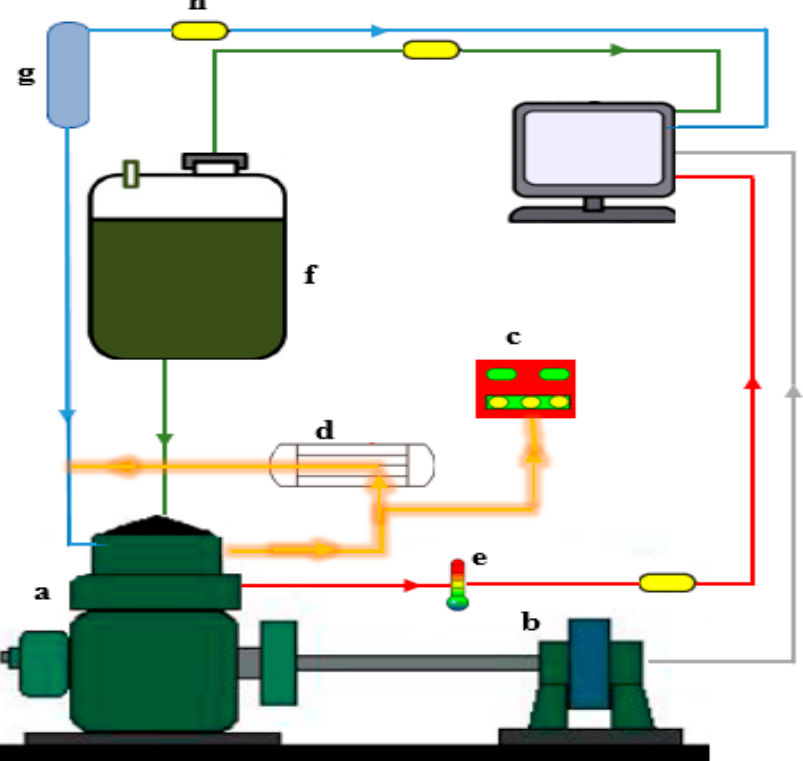
Table 4. Speci fi cation of the Testo 350 emission analyzer.